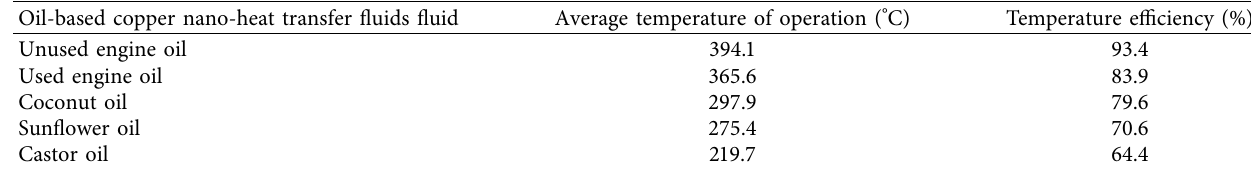
Table 3: Temperature efficiencies of nanofluids at average operational temperatures.